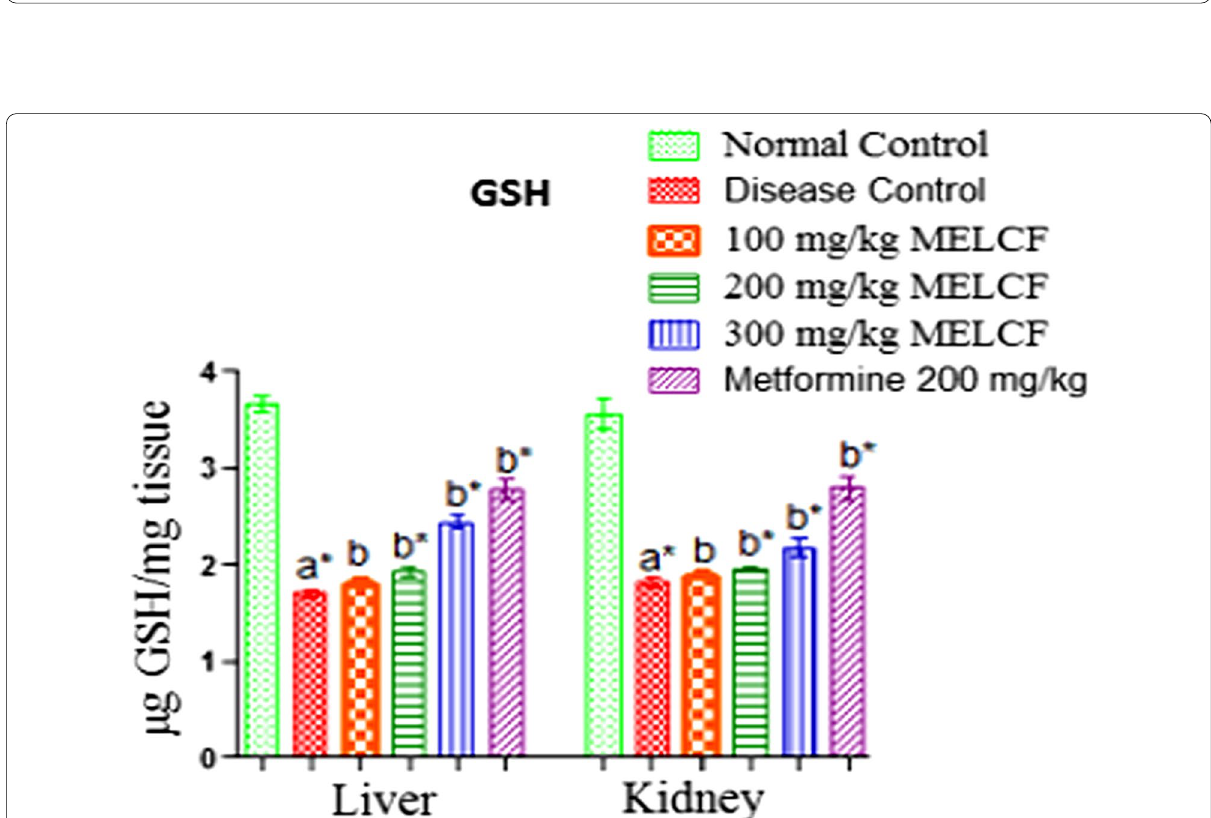
Fig. 13 Effect of MELCF on SOD. The values represented as mean when compared to disease/diabetic control